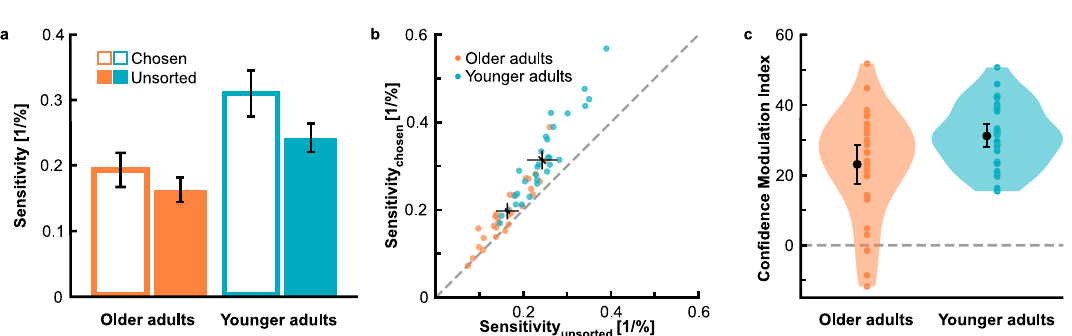
Figure 5. Contrast sensitivity and confidence. ( a ) Average contrast sensitivity as a function of age group and confidence set; open bars illustrate data from the chosen confidence set, closed bars represent data from the unsorted confidence set. ( b ) Contrast sensitivity for the chosen confidence set plotted against contrast sensitivity for the unsorted confidence set; each dot represents data from an individual participant, data for older and younger adults are plotted in different colours; dashed line marks the identity line; black closed dots give average sensitivities in each age group. ( c ) Confidence Modulation Index (CMI) as a function of age group; CMIs give the percental sensitivity increase from the set of unsorted trials to the set of chosen trials; coloured dots illustrate individual data and black dots represent the mean; shaded areas display 95% of the data distribution smoothed by a kernel density function. Error bars give 95% confidence